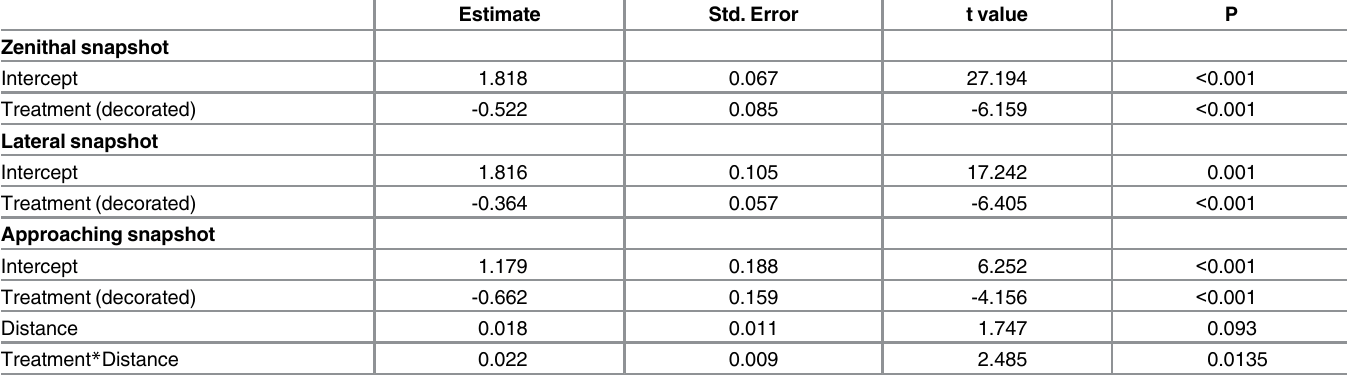
Table 2. Latency to nest detection by human observers in relation to decoration treatment (decorated and non-decorated) and distance to the nest. Three models were run to analyses independently the detectability of the nests from: zenithal snapshots (50m AGL), lateral snapshots (15m and 10m AGL) and approaching snapshots (75, 55, 35m and 22, 18, 14m AGL)